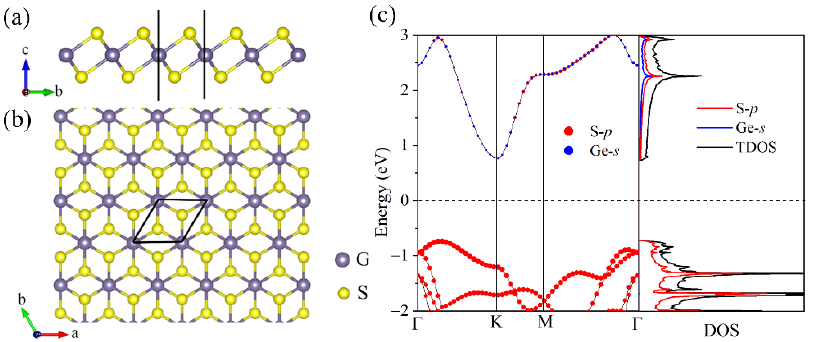
Figure 1. The structure of GeS 2 monolayer’s ( a ) side and ( b ) top views. ( c ) The atom orbitals’ project band structure and DOS for GeS 2 monolayer.